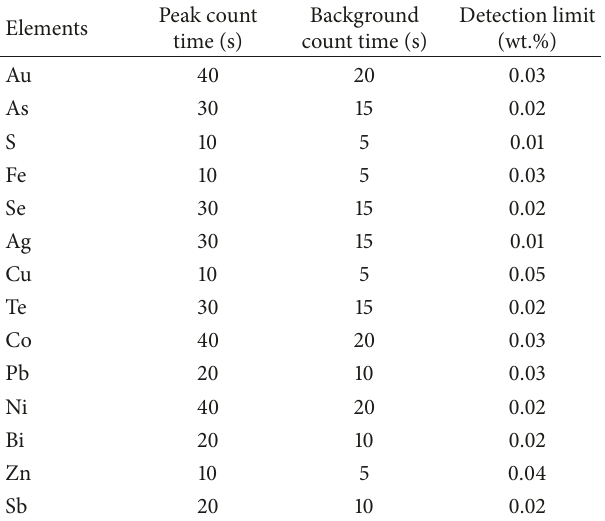
Table 2: Detection limits of EPMA analyses of minerals that host gold and that occur with